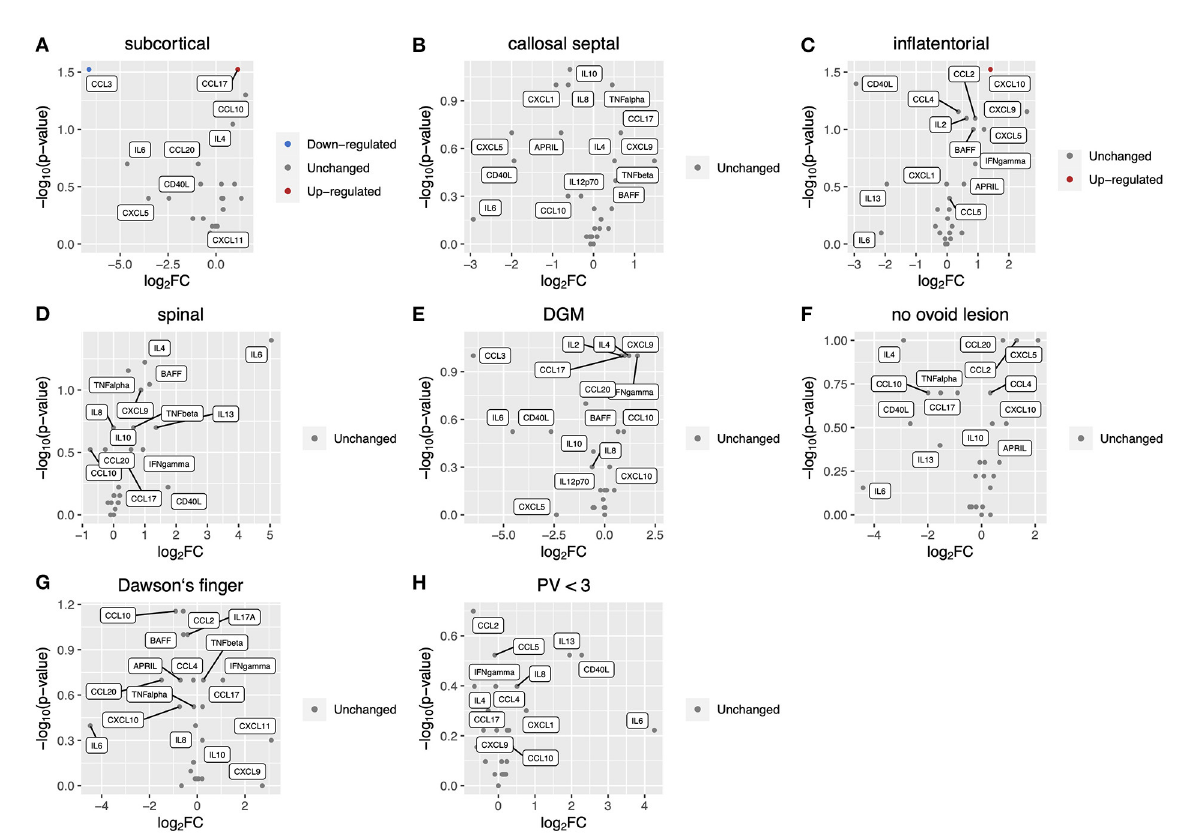
FIGURE2 Correlation of CSF inflammatory profile with radiological findings in NMOSD patients. Volcano plot showing log2 (fold change, FC) against –log10 ( p -value) of CSF inflammatory profile based on radiological findings as follows: (A) , subcortical lesion; (B) , callosal septal lesion; (C) , inflatentorial lesion; (D) , spinal lesion; (E) , DGM lesion; (F) , no ovoid lesion; (G) , Dawson’s finger; (H) , less than three PV. Red or blue indicates elevation or reduction, respectively, of cytokine/chemokine levels with a significant FC (|FC| > 1.5) and p -value ( < 0.05). CSF, cerebrospinal fluid; NMOSD, neuromyelitis optica spectrum disorder; DGM, deep gray matter lesion; PV, periventricular lesions; CE,